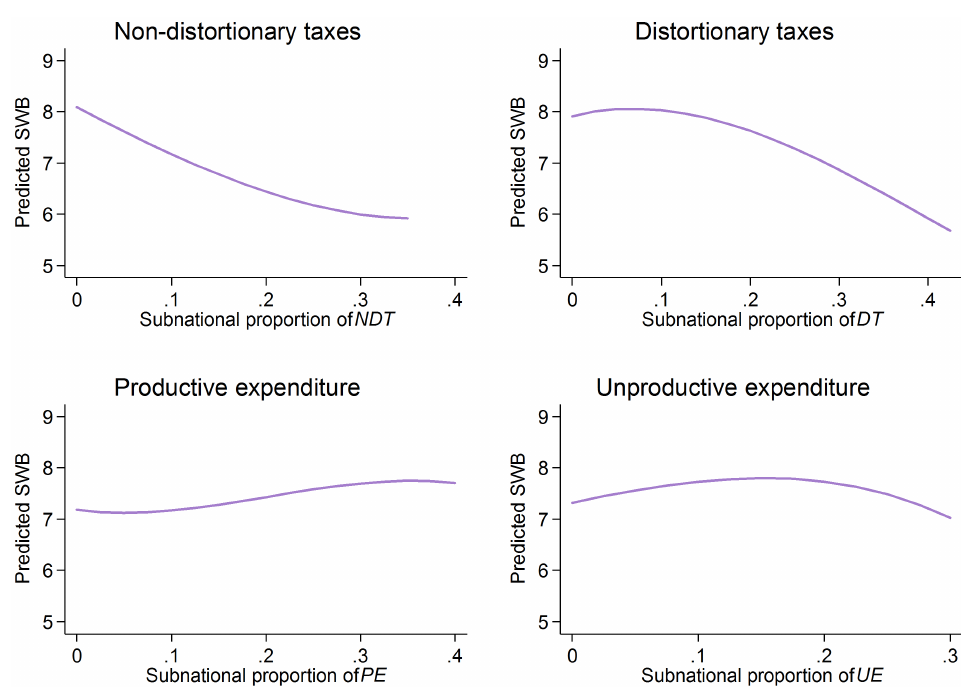
Figure 5: Predicted effects of varying subnational fiscal